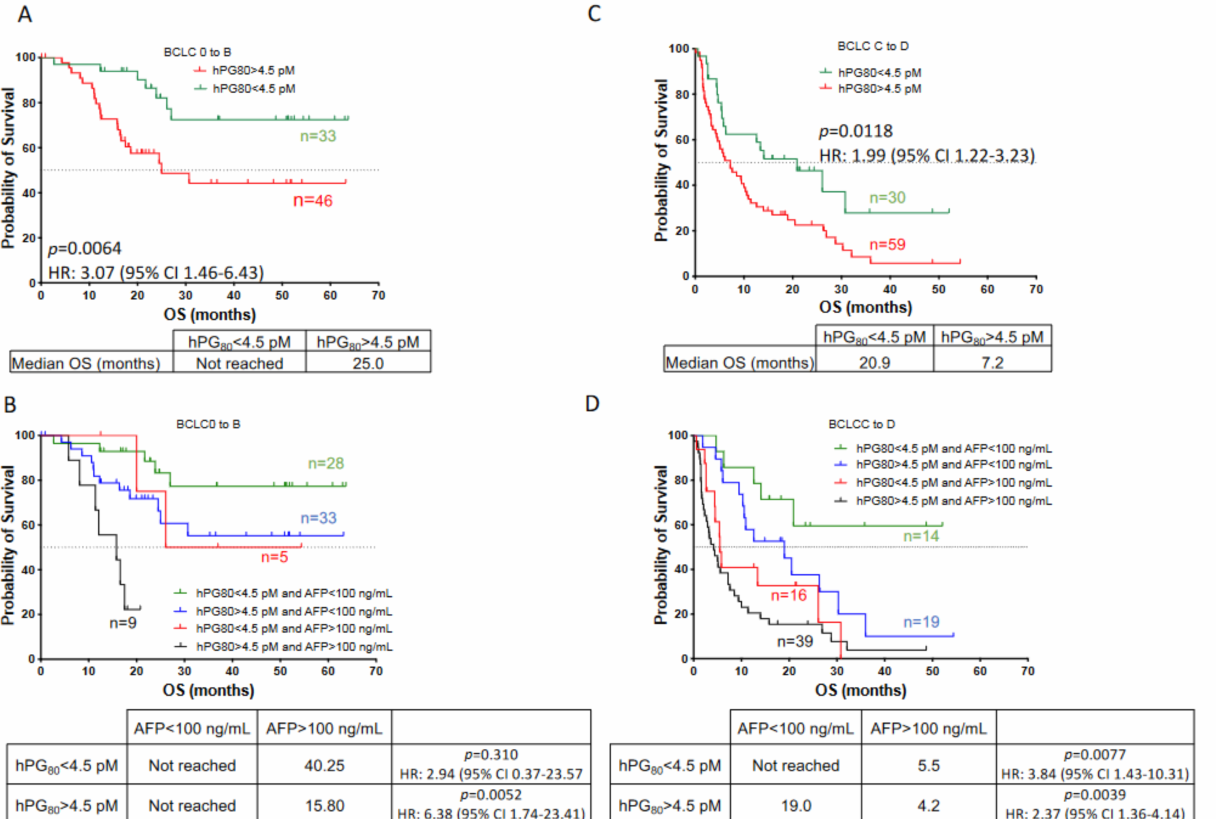
Figure 6. Overall survival of HCC patients with early to intermediate BCLC stages (BCLC 0 to B) and with advanced to terminal BCLC stages (BCLC C to D) according to hPG 80 alone or in combination with AFP levels. ( A ) Kaplan-Meier analysis of OS for HCC patients with very early to intermediate BCLC stages (BCLC 0 to B, n = 79) according to hPG 80 levels. Patients were divided into two groups based on hPG 80 levels (cutoff: 4.5 pM; hPG 80 < 4.5 pM: n = 33; hPG 80 > 4.5 pM: n = 46). ( B ) Kaplan- Meier analysis of OS for HCC patients with BCLC 0 to B according to hPG 80 and then to AFP levels (hPG 80 < 4.5 pM and AFP < 100 ng/mL: n = 28; hPG 80 < 4.5 pM and AFP > 100 ng/mL: n = 5; hPG 80 > 4.5 pM and AFP < 100 ng/mL: n = 35, hPG 80 > 4.5 pM and AFP > 100 ng/mL: n = 9). ( C ) Kaplan-Meier analysis of OS for HCC patients with advanced or terminal BCLC stages (BCLC C to D, n = 89) according to hPG 80 levels. Patients were divided into two groups based on hPG 80 levels (cutoff: 4.5 pM; hPG 80 < 4.5 pM: n = 30; hPG 80 > 4.5 pM: n = 59). ( D ) Kaplan-Meier analysis of OS for HCC patients with BCLC C to D according to hPG 80 and then to AFP levels (hPG 80 < 4.5 pM and AFP < 100 ng/mL: n = 14; hPG 80 < 4.5 pM and AFP > 100 ng/mL: n = 16; hPG 80 > 4.5 pM and AFP < 100 ng/mL: n = 19, hPG 80 > 4.5 pM and AFP > 100 ng/mL: n =